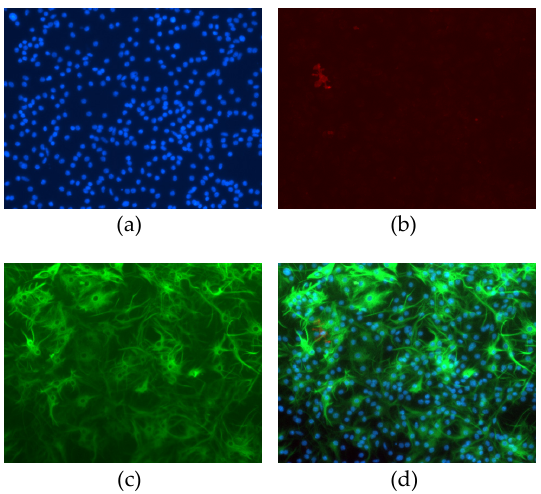
Figure 1. Non-neuronal neonatal cells after magnetic isolation and 15 days cultured in vitro. Cells were stained with ( a ) DAPI (blue), ( b ) CD11b (red), or ( c ) GFAP (green). Panel ( d ) represents merged images.